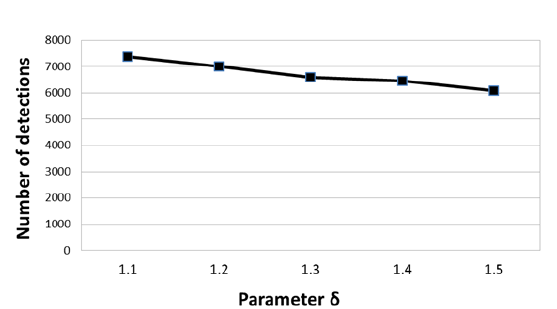
Figure 8: Number of anomalous warning events.